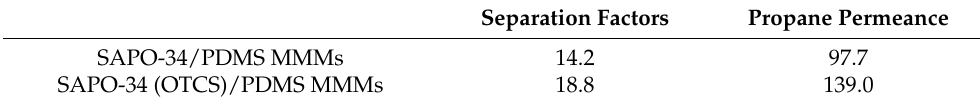
Table 1. Separation performance of the MMMs filled with SAPO-34 and OTCS-modified SAPO-34. Separation Factors Propane Permeance